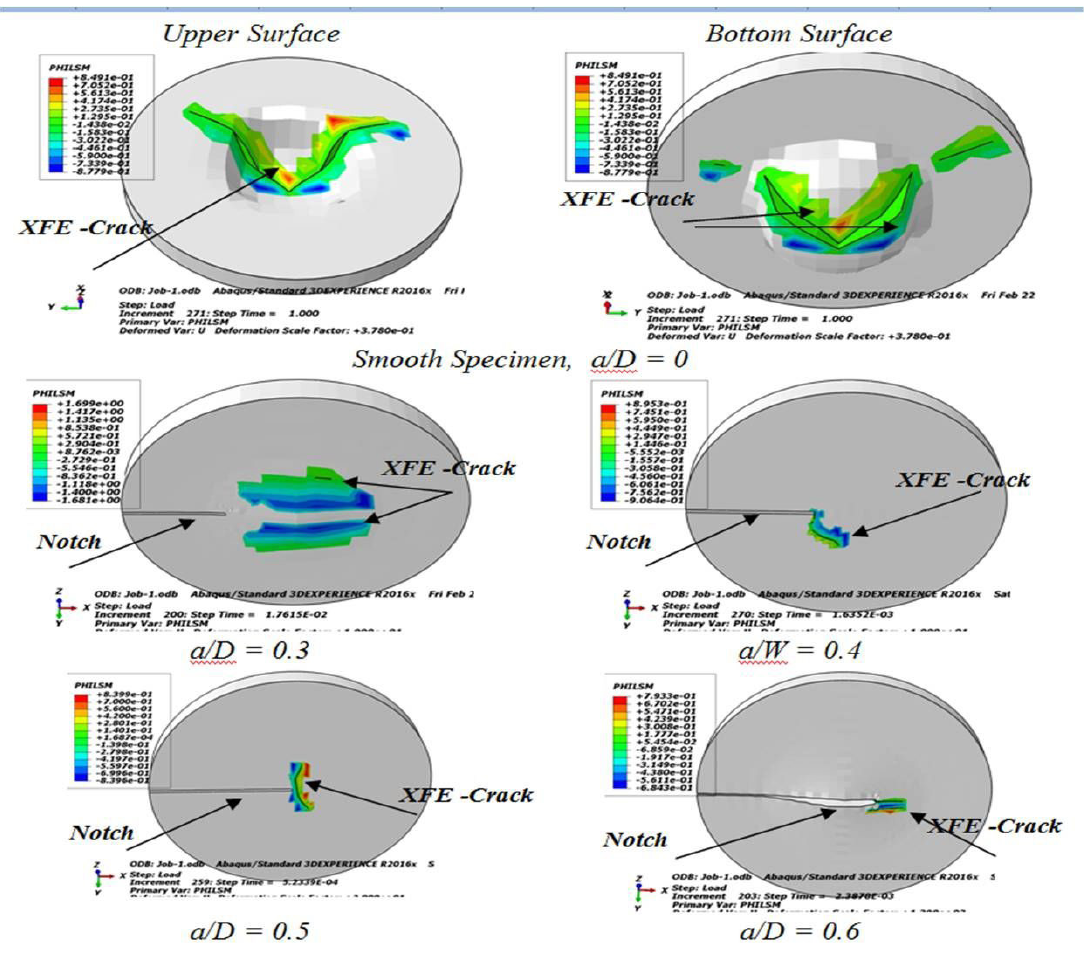
Figure 19. Site of crack initiation and crack path based on XFEM of SEN specimen.